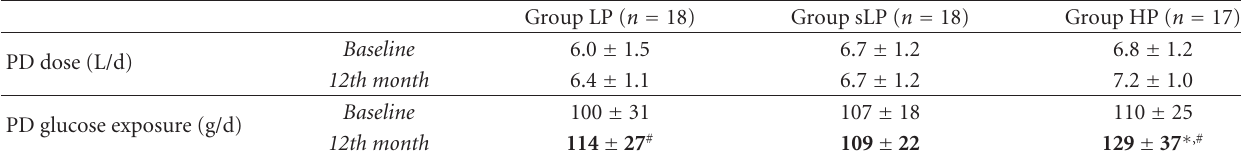
Table 3: Changes of PD dose and PD glucose exposure in the 53 PD patients, grouped according to the diet which they are randomized to during 12 month